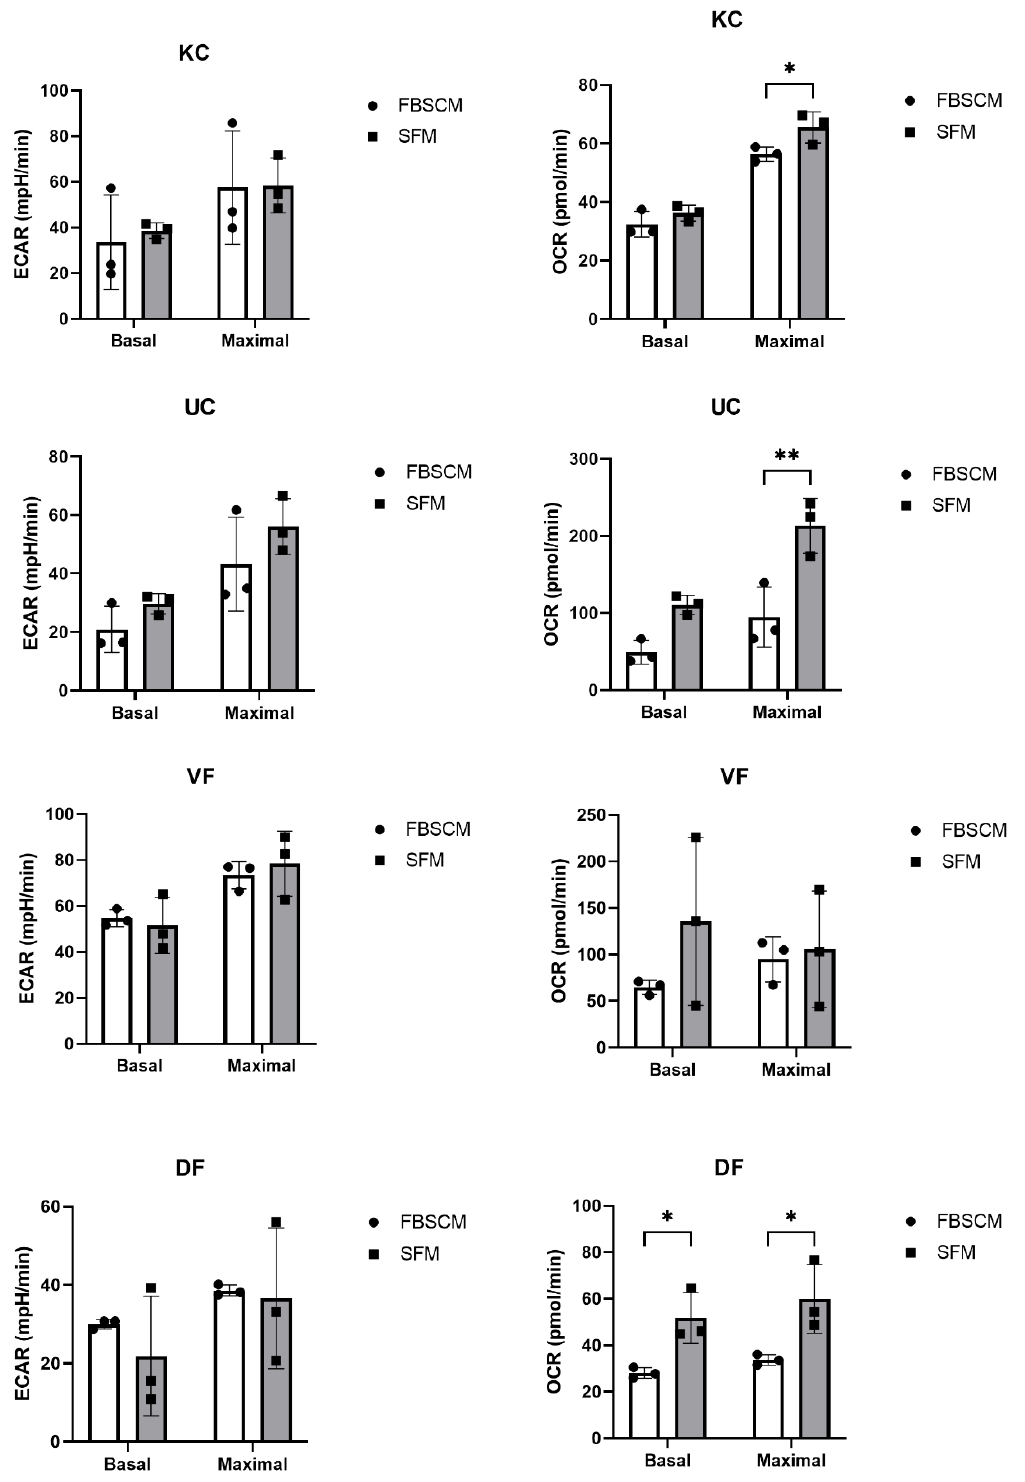
Figure 5. Extracellular acidification rate (ECAR) and oxygen consumption rate (OCR) evaluations of cell culture of keratinocytes (KC), urothelial cells (UC), dermal fibroblasts (DF) and vesical fibroblasts (VF). Ordinary two-way ANOVA was used to interpret the data. Asterisks indicate significant differences: (*) for p -value < 0.05, (**) for p -value < 0.01. Each experiment had five replicates for the three cell populations per cell type (N = 3, n =